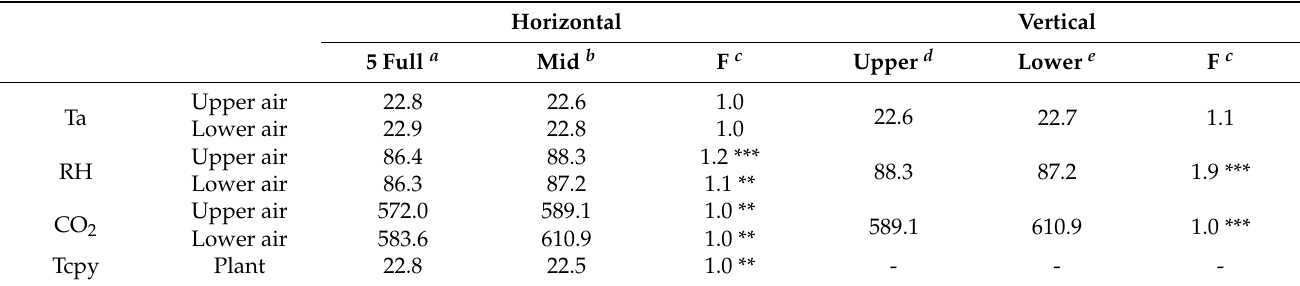
Table 4. Statistical significance test of sensor value at the mid-center